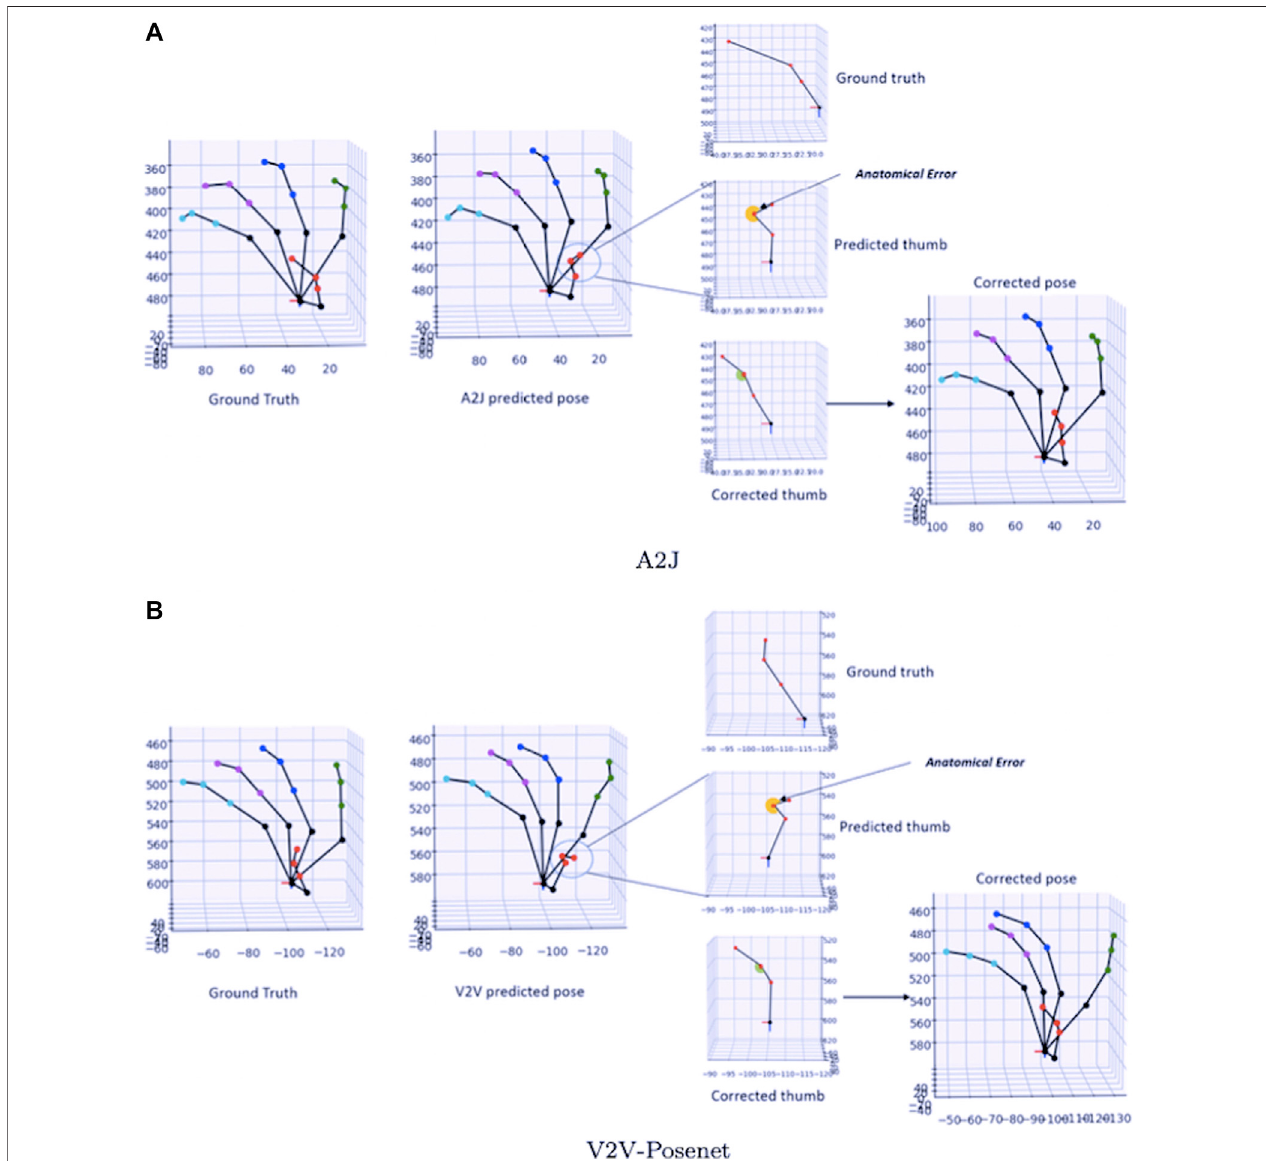
FIGURE4| Thetypeofcorrectionsperformedbytheanatomical fi lter. (A) showsthecorrectionbytheA2Jmodeland (B) showsthecorrectionoftheV2V-Posenet model. The dotted circles indicate an anomaly in the joint. In the zoomed graph, the yellow semi-circle denotes the joint which has an error, and the green semi-circle denotes the corrected